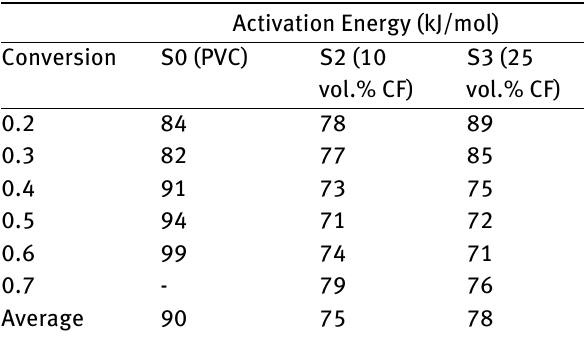
Table 3: Apparent activation energy (Ea), for pure and nanocompos- ite samples, at different values of conversion ( α